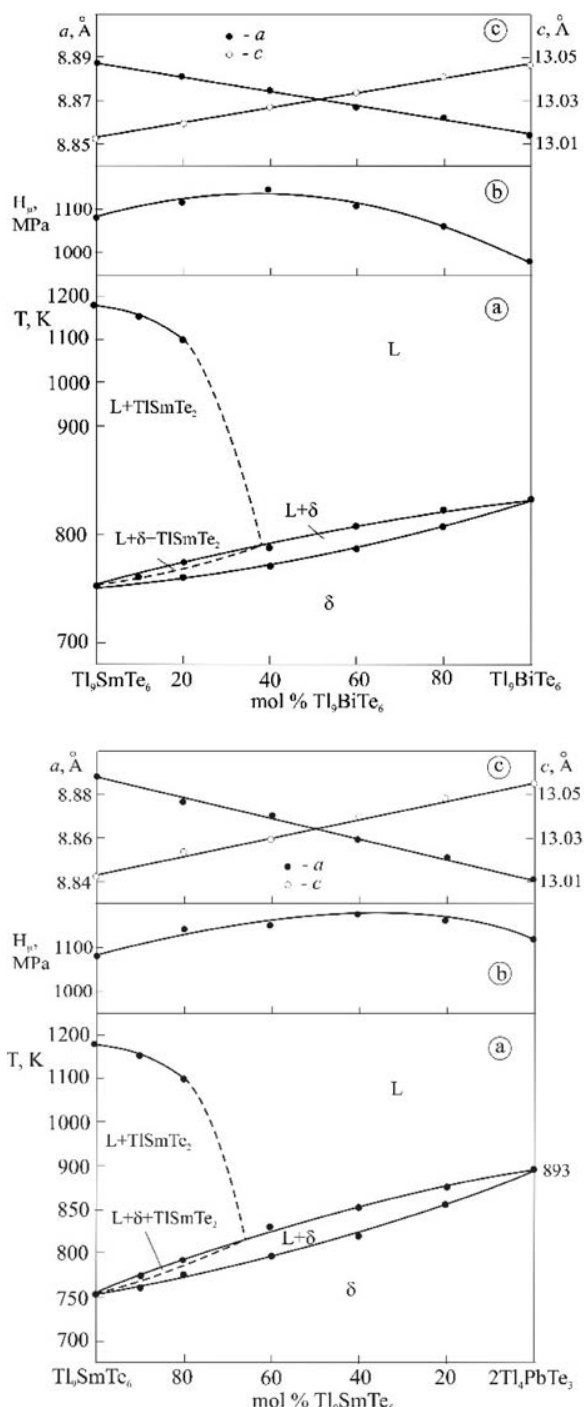
Fig. 1. Polythermal sections (a), concentration dependencies of mi- crohardness (b), and lattice parameters (c) for the alloys of the Tl 9 S- mTe 6 -Tl 9 BiTe 6 and Tl 4 PbTe 3 -Tl 9 SmTe 6 sections of the Tl-Pb-Bi-Sm- Te